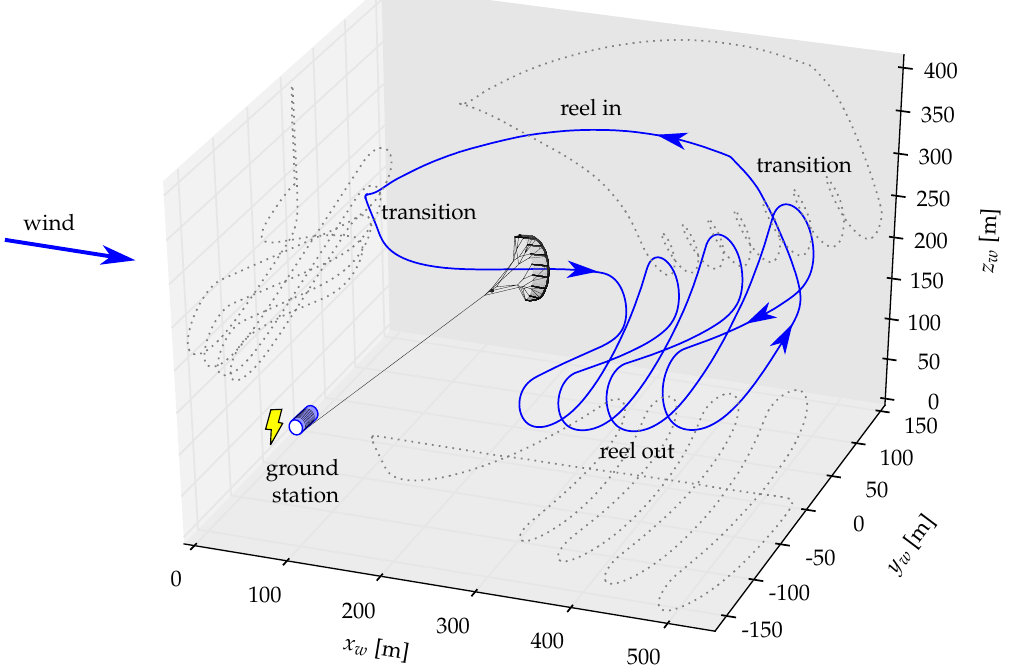
Figure 1. Computed flight path of a kite power system using a flexible wing with suspended kite control unit and single tether (kite and drum not to scale)